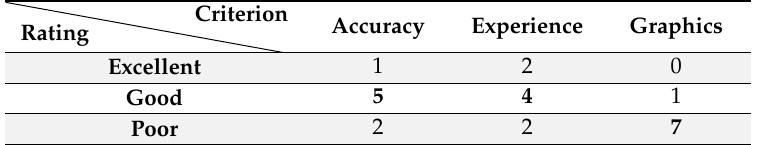
Table 2. Summarized number of users’ rating on 3ds Max (Unit: person / people).